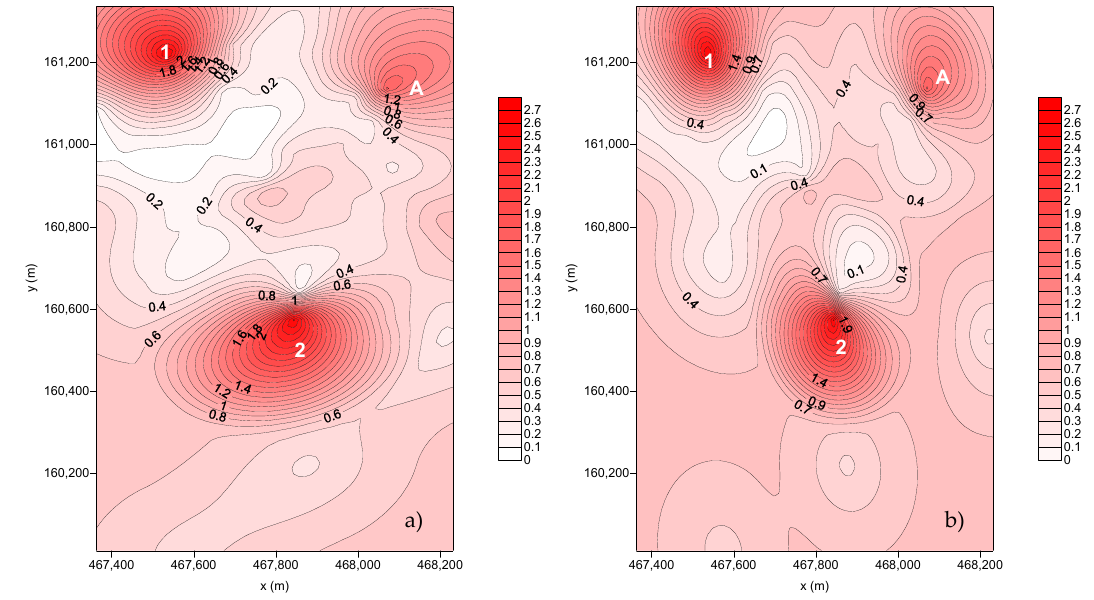
Figure 6. Spatial distribution of the dust flux deposition (g m –2 month –1 ): ( a ) SC4 and ( b ) SC5. From the dispersion of the deposition flux of SC4, it is possible to observe that are two points with preferential deposition and one wider deposition area